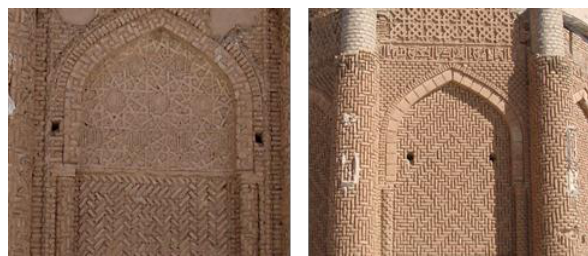
Figure 2. Brick work of the Eastern Kharraqan Tomb Tower, each side has its own unique decoration They belong to Seljuk period, and their construction dates back to the 11 th century. The eastern tomb (the right one in figure 2) is the older one and dates back to the 1067- 68 AC; while the western tomb (the left one in figure 2) was constructed 26 years later in 1093 AC. It seems that these two mausoleum towers are of the oldest double-domed buildings in Iran. Although these towers are similar to each other, they are significantly different in some cases (exp. In ornamental brick-work, their heights, etc.).